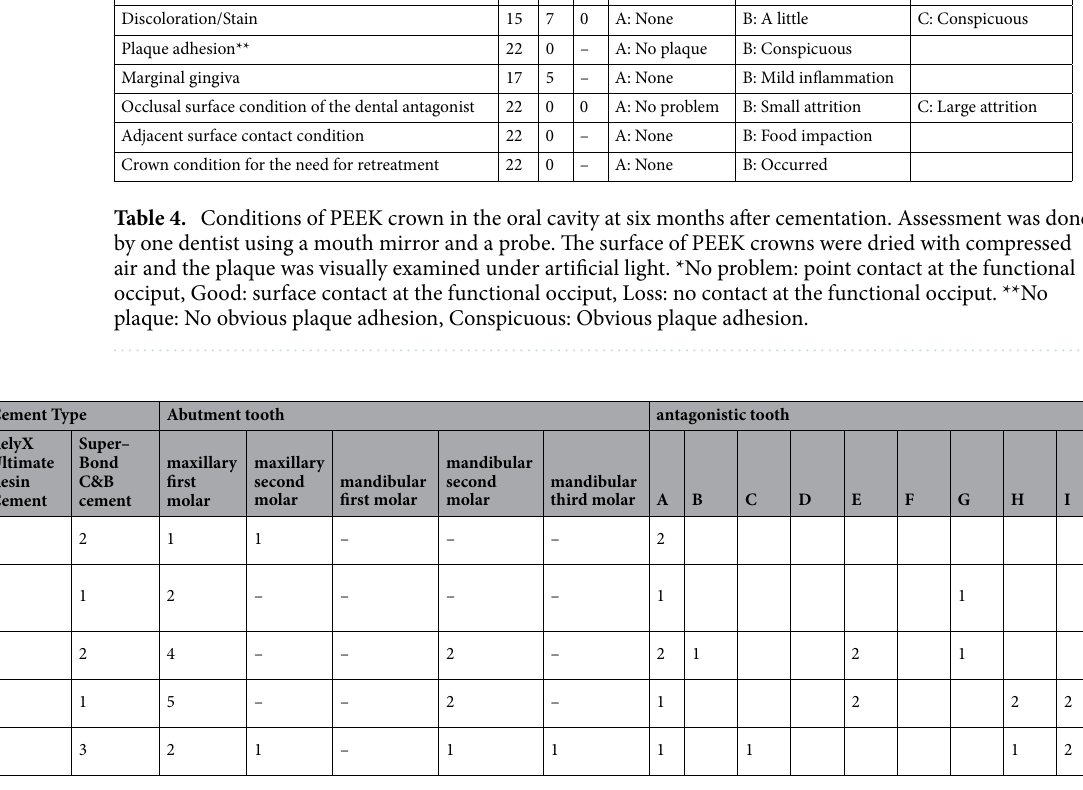
Table 5. Details of score B evaluation items for six months after cementation. A full metal crown, B temporary crown, C ceramic crown, D hard resin teeth, E natural tooth, F PEEK crown, G zirconia crown, H partially covered metal crown, I ceramic-fired cast crown.